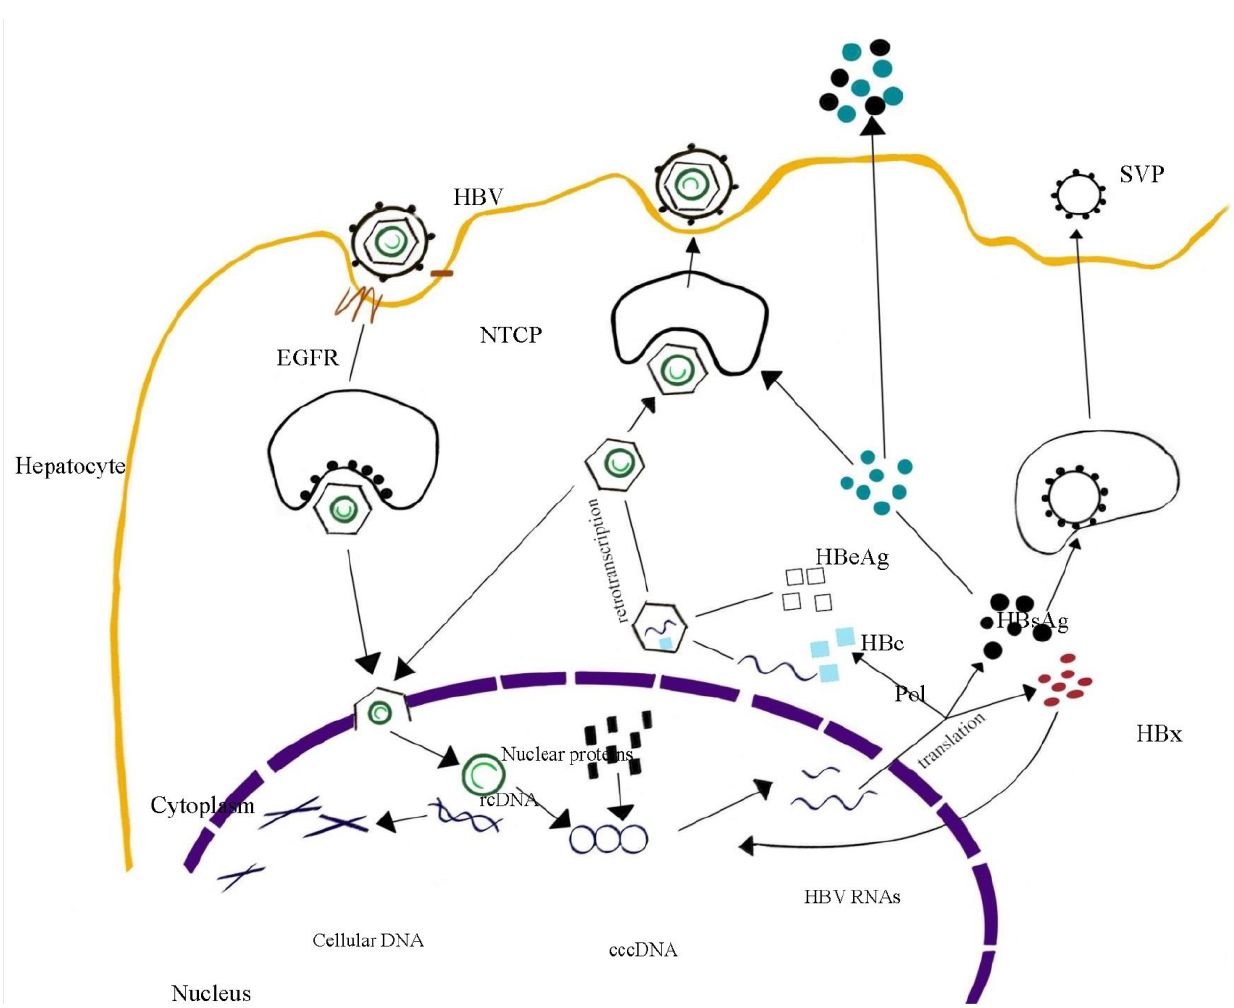
Figure 1. The replicative cycle of hepatitis B virus (HBV). Details about the various phases of this process are described in the text. HBV: hepatitis B virus; EGFR: epithelial growth factor receptor; NTCP: sodium/taurocholate cotransporting polypeptide; rcDNA: relaxed circular deoxyribonucleic acid; cccDNA: covalently closed circular DNA; HBV RNAs: HBV ribonucleic acids; Pol: viral polymerase; HBx: hepatitis B protein x; HBc: hepatitis B core protein; HBeAg: hepatitis B E antigen; HBsAg: hepatitis B surface antigen; SVP: small vesicle